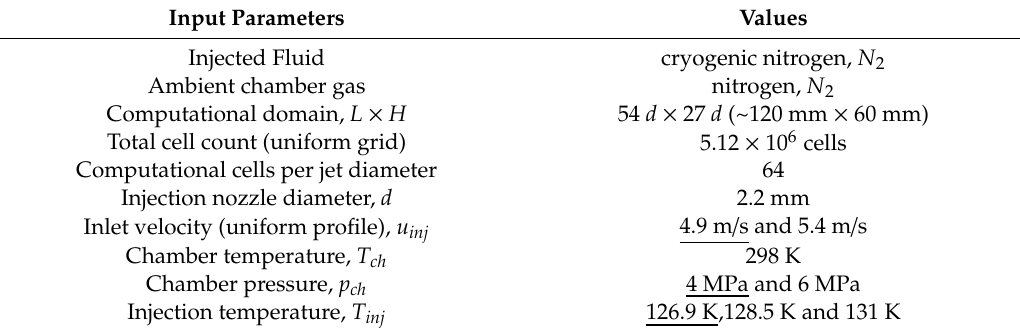
Table 2. Working parameters of the cryogenic nitrogen injection case, from Mayer et al.